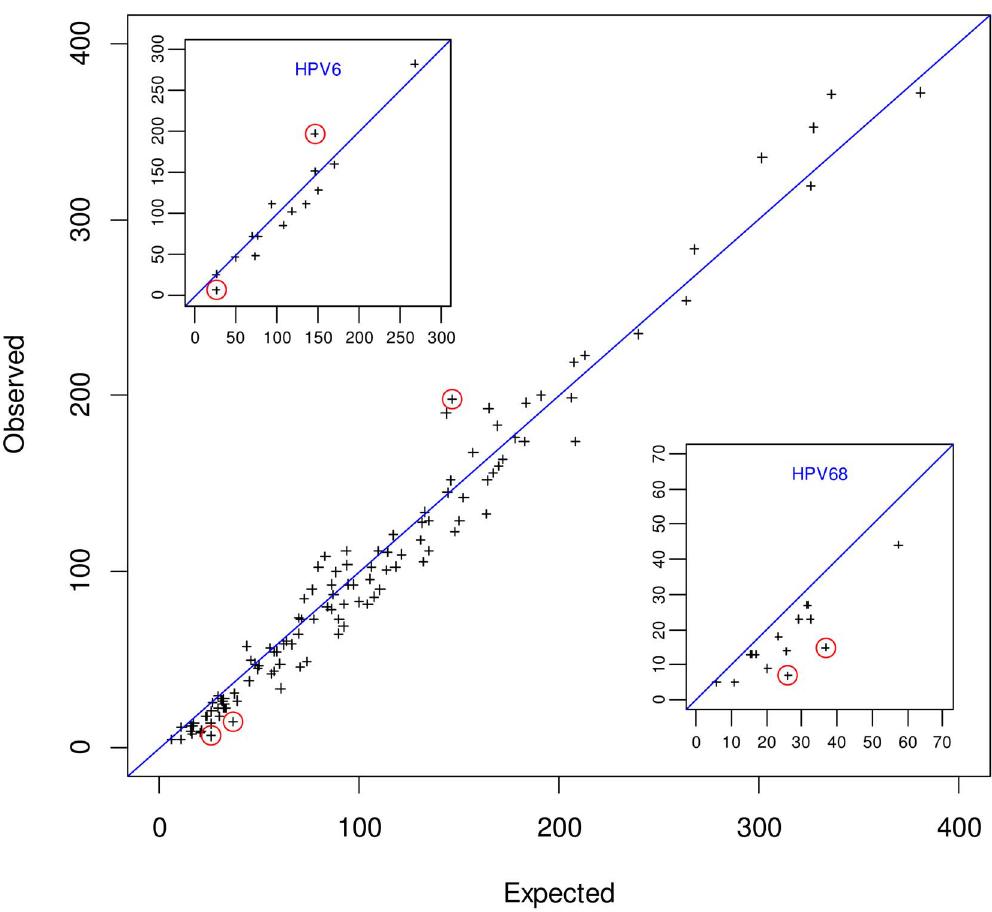
Figure 2. Observed versus expected occurrence for 2-type human papillomavirus infections, 31,717 samples from women, Sweden. Plus signs represent occurrences of HPV pairs. HPV pairs located in the upper triangle indicate positive clustering, while those located in the lower triangle represent negative clustering between the HPV types involved. Three of the p-values for joint HPV infections were significant at the chosen significance level of 0.0004: one positive clustering involving HPV6 with 18; two negative clustering involving the following pairs: HPV51/68, and HPV6/68. Overlaid on the main figure are the occurrences relative to HPV68 (small box on the bottom-right, scaled from 0 to 70) and to HPV6 (small box on the top-left, scaled from 0 to 300). To note, the significant negative cluster involving HPV6/68 appears on both small boxes. HPV68 showed a general tendency to be involved in negative clustering with all other types. The same behaviour was not observed for any other HPV type, including HPV6 that was also involved in 2 significant co-infections, but in opposite